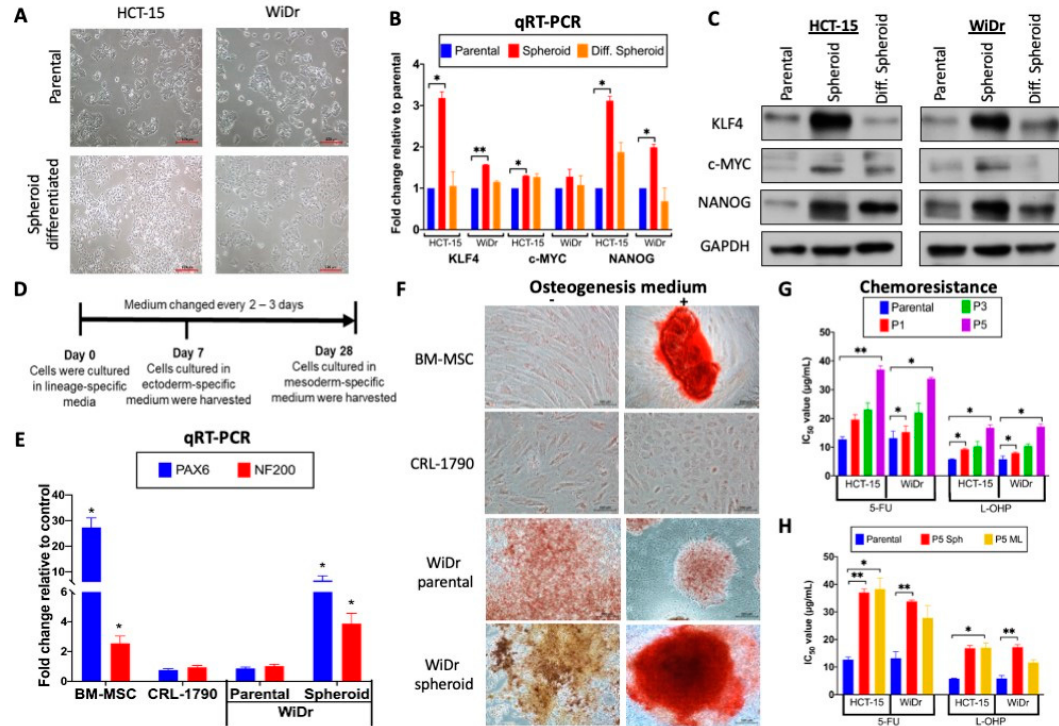
Figure 2. Di ff erentiation abilities and chemoresistance of the CRC spheroid cells. ( A ) Serum-induced differentiation reverted the morphology of the spheroid cells to that of the parental CRC cells. Induced differentiation was achieved by culturing the CRC spheroid cells in a serum-containing medium (see Materials and Methods), and the morphologies of the cells are shown (bars: 100 μ m). ( B ) Up-regulated expression of pluripotency genes in the CRC spheroids and in serum-induced differentiated cells analyzed in ( B ) qRT-PCR and ( C ) western blots. ( D – F ) Lineage-directed differentiation of the CRC spheroid cells. ( D ) Timeline and culture conditions of the lineage-directed differentiation experiments. The ectoderm-directed differentiation was achieved in 7 days of culture before the cells were harvested for qRT-PCR analysis ( E ); mesoderm-directed differentiation was analyzed by staining after 28 days ( F ). ( E ) Ectodermic differentiation of the WiDr spheroid cells. Relative expression levels of the ectoderm-specific markers, PAX6 and NF-200, in WiDr spheroids and WiDr spheroid-differentiated cells relative to non-cancerous colonic CRL-1790 cells, used as the controls, are shown. The bone marrow-derived mesenchymal stem cells (BM-MSC) were included as a positive control. The expression levels were normalized to those of CRL-1790, set as 1.0. ( F ) Mesodermic differentiation of the CRC spheroid cells. CRC spheroid cells were differentiated into the mesoderm-derived osteocytes visualized by Alizarin Red staining on day 28. (bars: 100 μ m). The control was cells cultured in normal media. ( G , H ) Progressive enhancement of chemoresistance in CRC spheroids on extended culture. After treatment with 5-fluorouracil (5-FU) or oxaliplatin (L-OHP) at a concentration range of 0 to 100 µ g / mL and at different passages (P1, P3 and P5) of the spheroids, IC 50 values of the cells were obtained by MTT assays ( G ). Drug treatment was similarly performed on P5 monolayer (P5-ML) cells derived from the P5 spheroids (P5 Sph) ( H ). In all subfigures, * p < 0.05 and ** p < 0.01 were values relative to the similarly treated parental CRC cells.